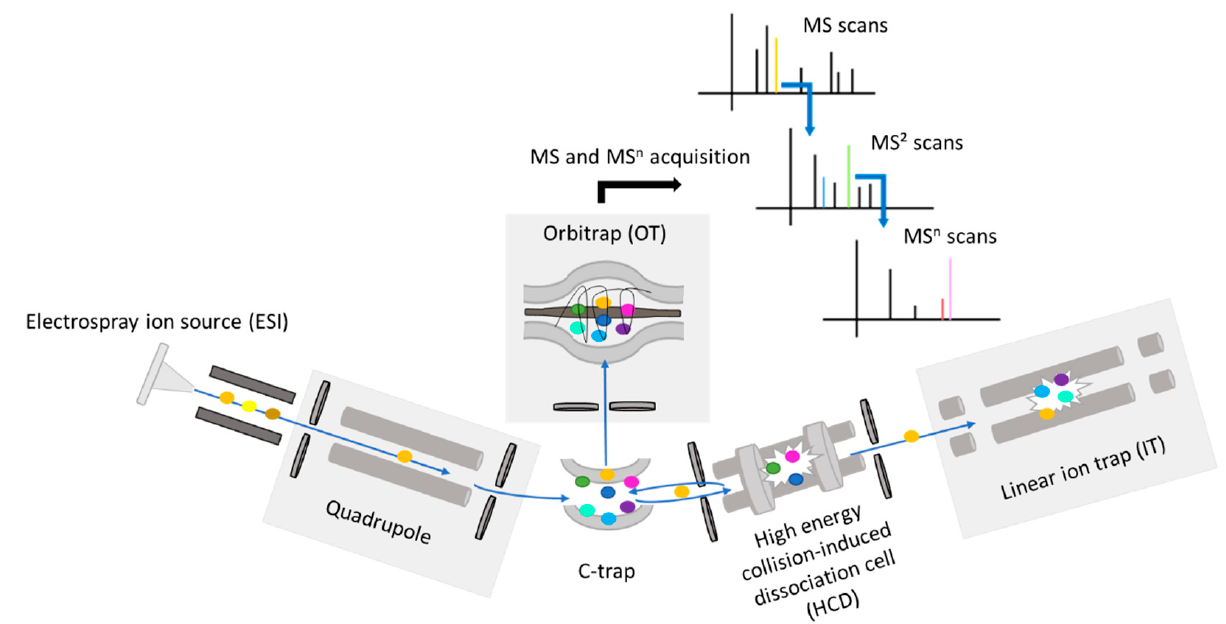
Figure 7. Schematic presentation for Orbitrap Fusion Lumos Tribrid TM mass spectrometer. For data-